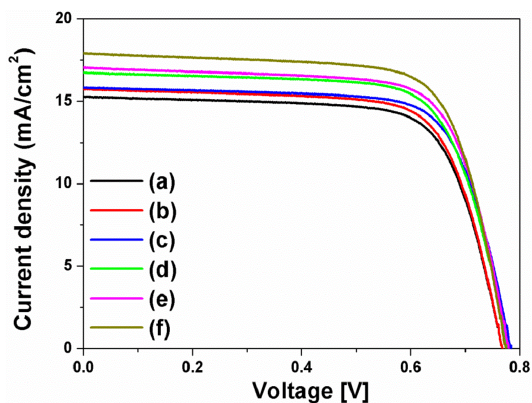
Figure 6. Current density-voltage curves of DSSCs based on a composite film structure: ( a ) without metal NPs, ( b ) with spherical Ag NPs, ( c ) with multi-shaped Ag NPs, ( d ) with Au NPs, ( e ) with spherical Ag and Au NPs, and ( f ) with multi-shaped Ag and Au NPs. Table 2. Photovoltaic properties of DSSCs based on a composite film structure.